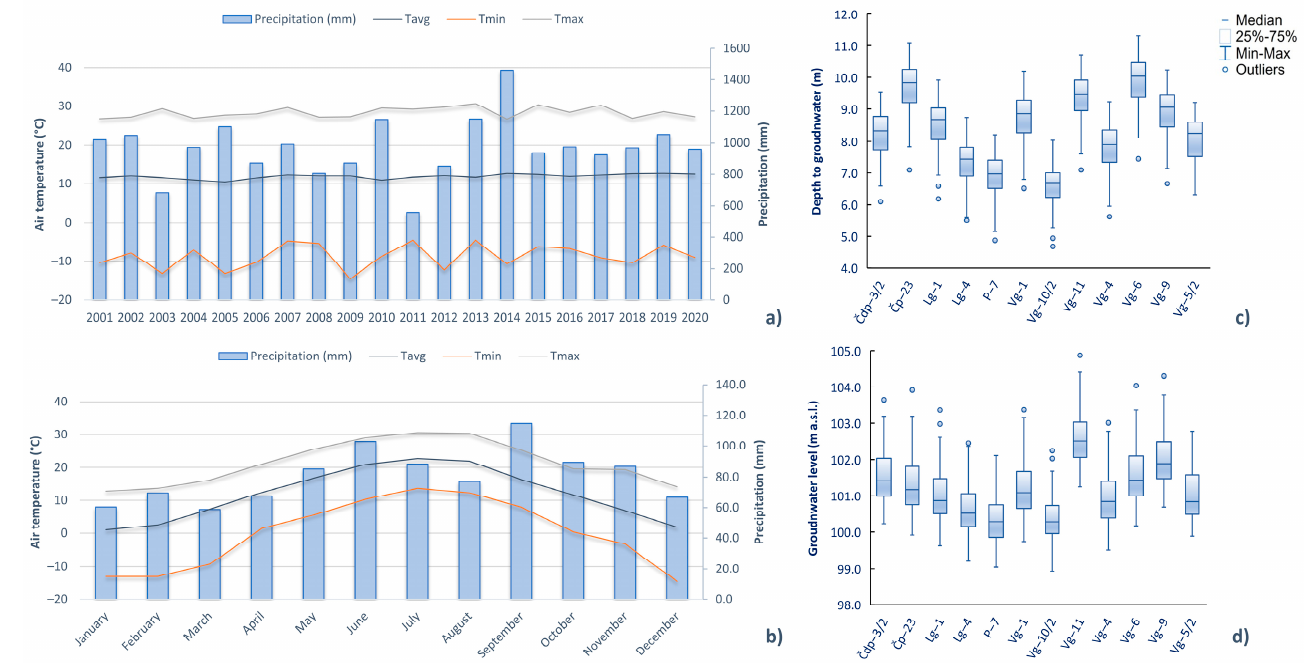
Figure 2. The annual precipitation ( a ) and the average monthly precipitation ( b ) with average, minimum and maximum air temperature; depth to groundwater ( c ) and groundwater levels ( d ) for the period 2001 to 2020.